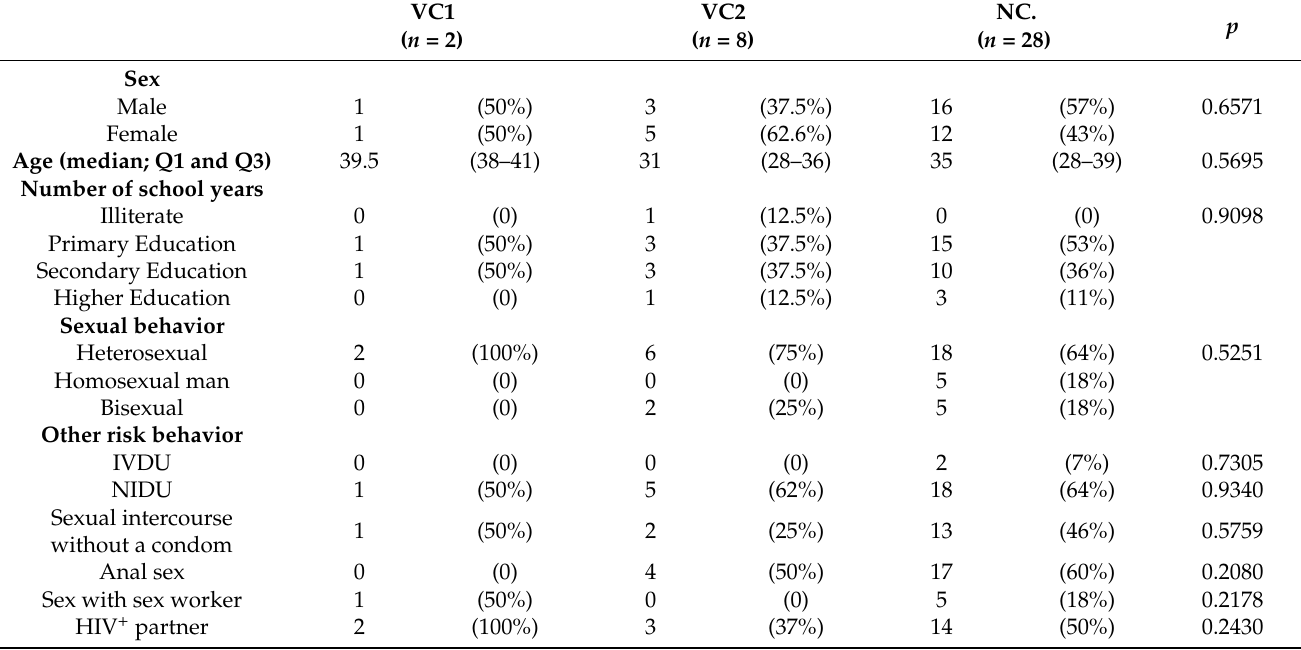
Table 1. Epidemiological and behavioral characteristics of HIV-1-infected individuals.